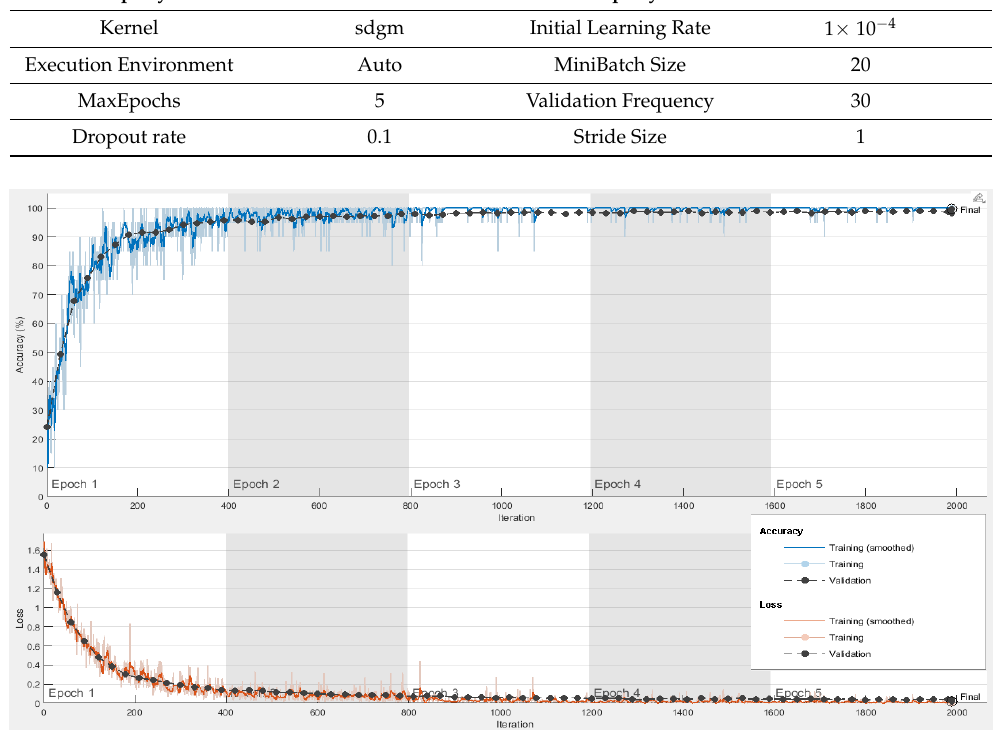
Figure 4. Training accuracy and loss function plots for DenseNet201